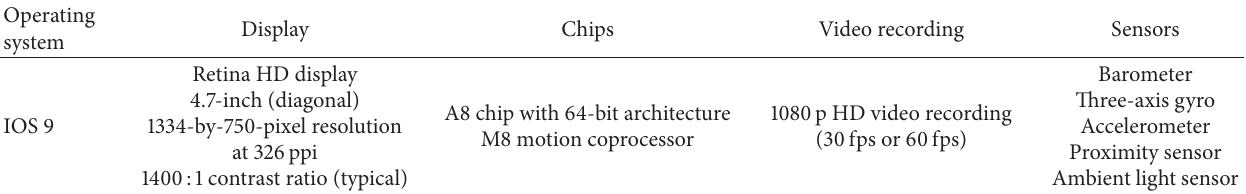
Table 1: Relevant parameters of iPhone 6.